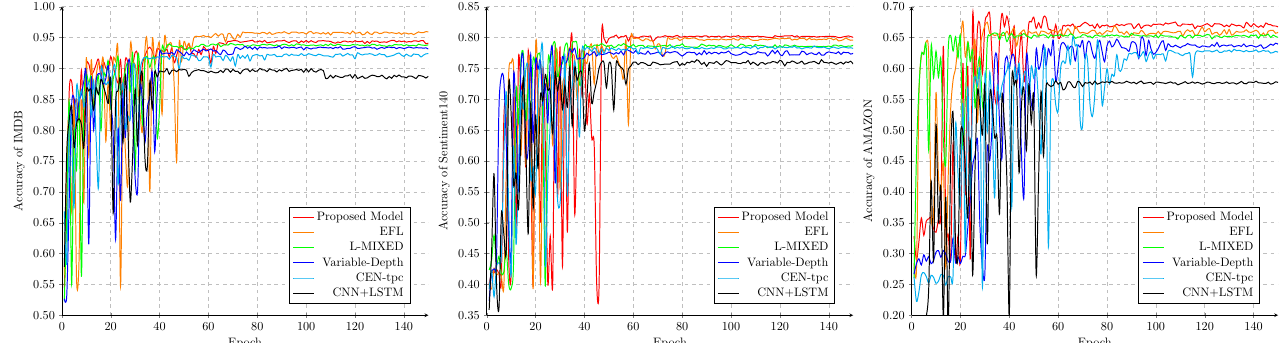
Figure 4. Complete tendency of accuracy for selected dataset trained by various